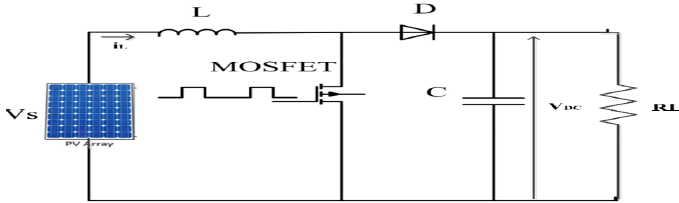
Figure 2. Direct current–direct current (DC–DC) boost converter circuit. MOSFET: metal-oxide- semiconductor field-effect